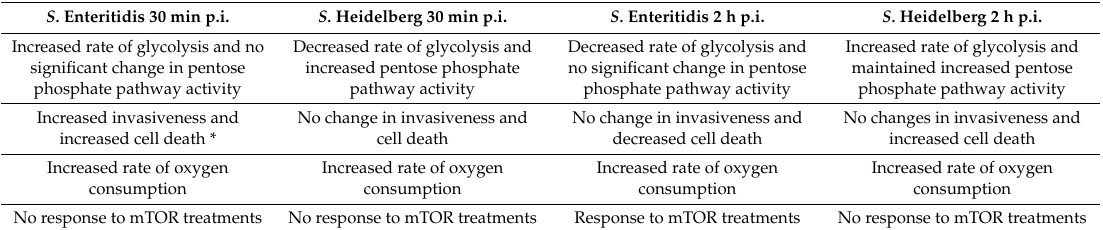
Table 5. Summary of chicken macrophage responses to infections by S. Enteritidis and S.